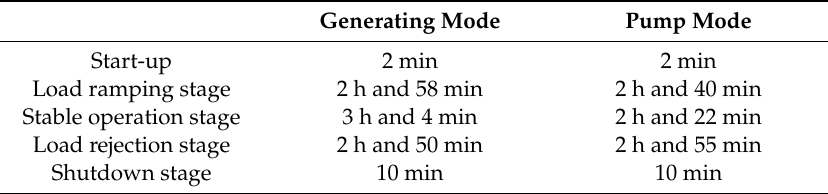
Table 3. Simulation time of each stage before model